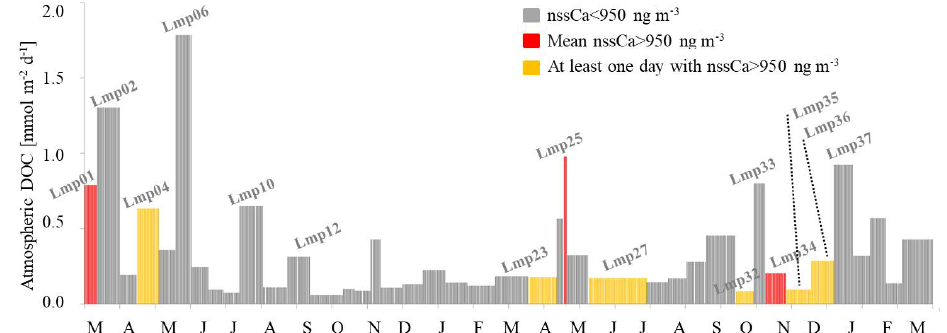
Figure 6. Temporal dynamics in the dust deposition events during the sampling period, color-coded based on the contribution of non-sea-salt Ca (nss Ca). The month abbreviation and tick marks correspond to the end of the corresponding month. The width of the bar refers to the length of the sampling period.